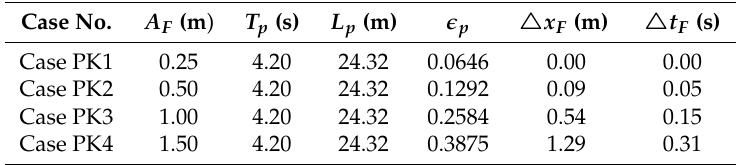
Table 2. The wave inputs and the absolute differences in the focusing points for the wave groups generated using the wave packet with different wave